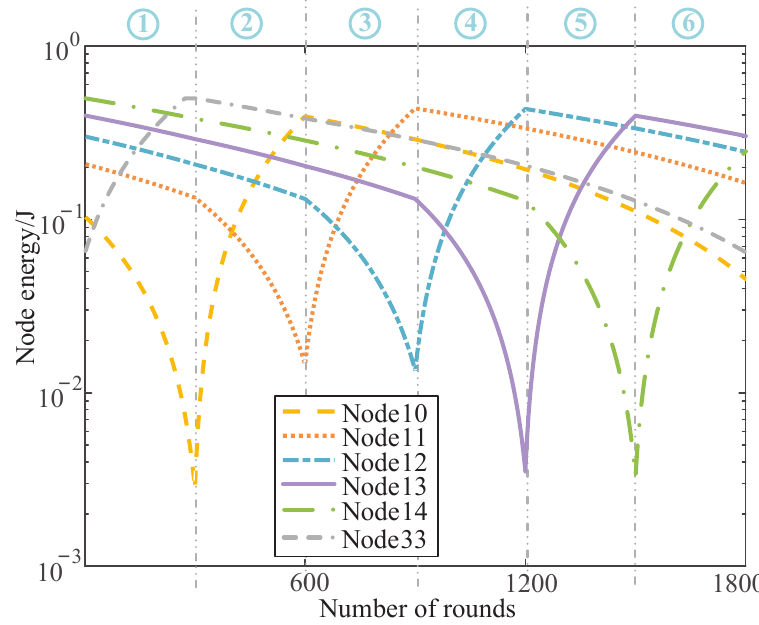
Figure 6. Residual energy of the node with energy